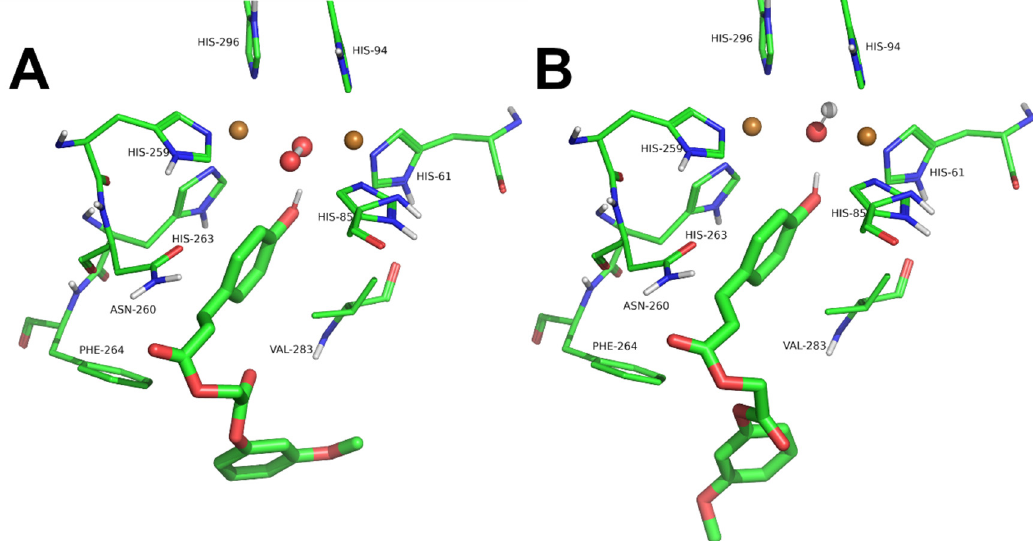
Figure 6. Docking of (2-(3-methoxyphenoxy)-2-oxoethyl-(E)-3-(4-hydroxyphenyl) acrylate) to oxy- tyrosinase ( A ) and met-tyrosinase ( B ). Colour scheme is as in Figure 3.